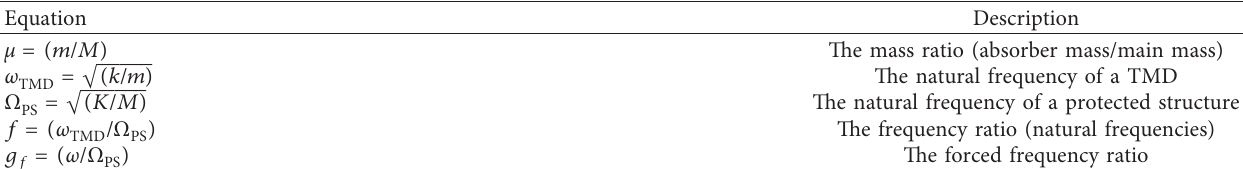
Table 1: Parameters of the TMD